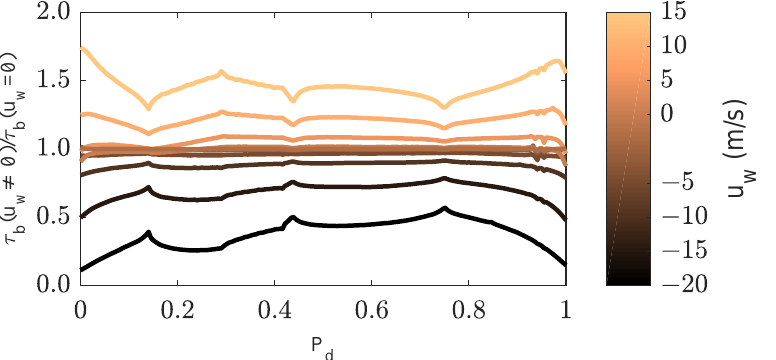
Figure 18. Bed shear stress considering wind effects respect the case with null wind for the experiment of Kean et al.